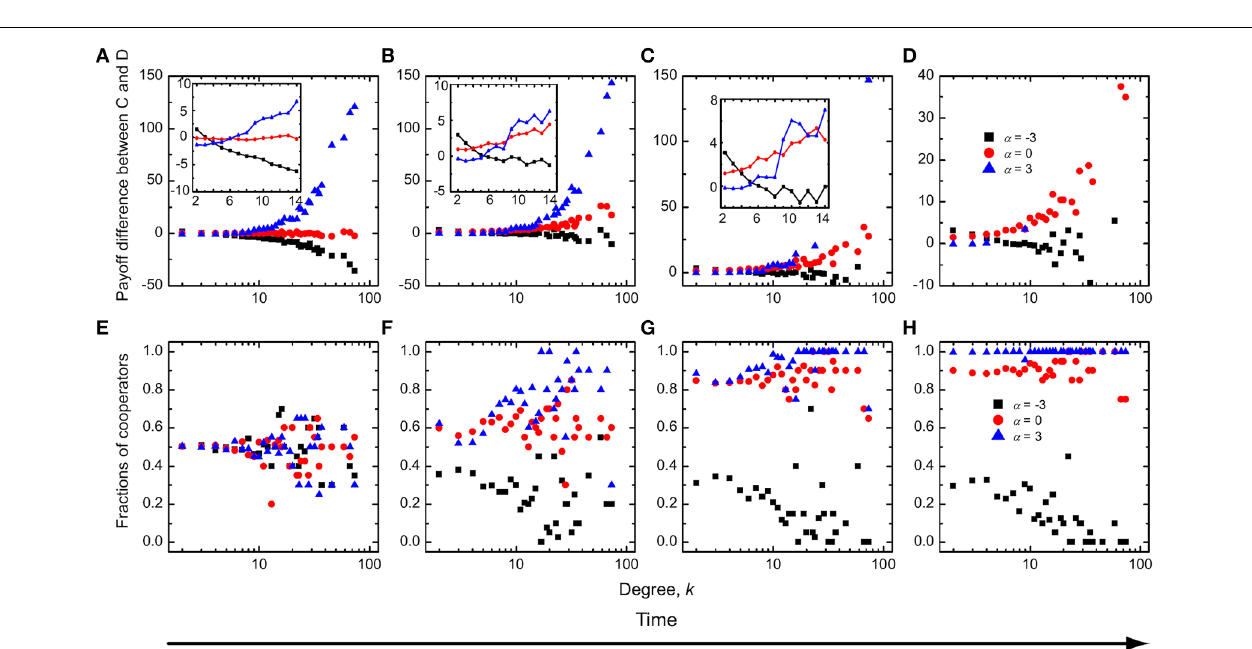
FIGURE 2 | Time evolution of the mean payoff difference between cooperatorsanddefectors(A–D)andthefractionofcooperators(E–H)asa functionofdegree k forthreetypicalvaluesof α . Institutionalrewardingand absolute payoffs apply. The insets of (A,B) show the mean payoff difference